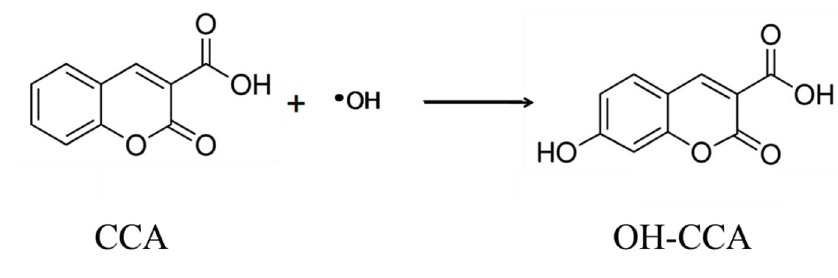
Figure 1. Probing reaction of OH radical with CCA (coumarin 3-carboxy acid) to form fluorescent molecule OH-CCA (7-hydroxy coumarin 3-carboxy